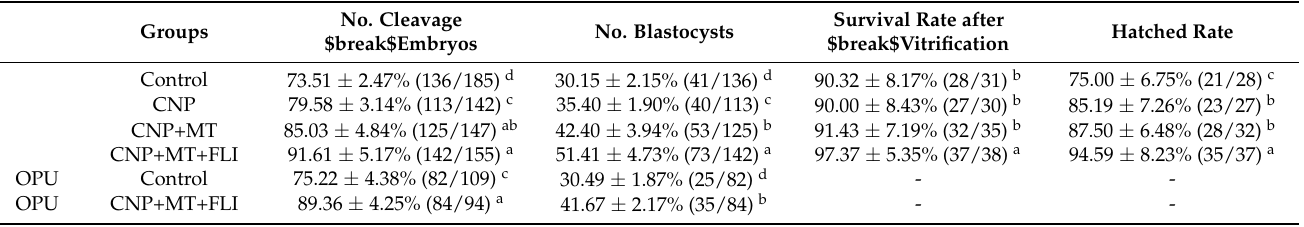
Table 3. The combination treatment of CNP, MT, and FLI on the developmental ability of bovine oocytes and